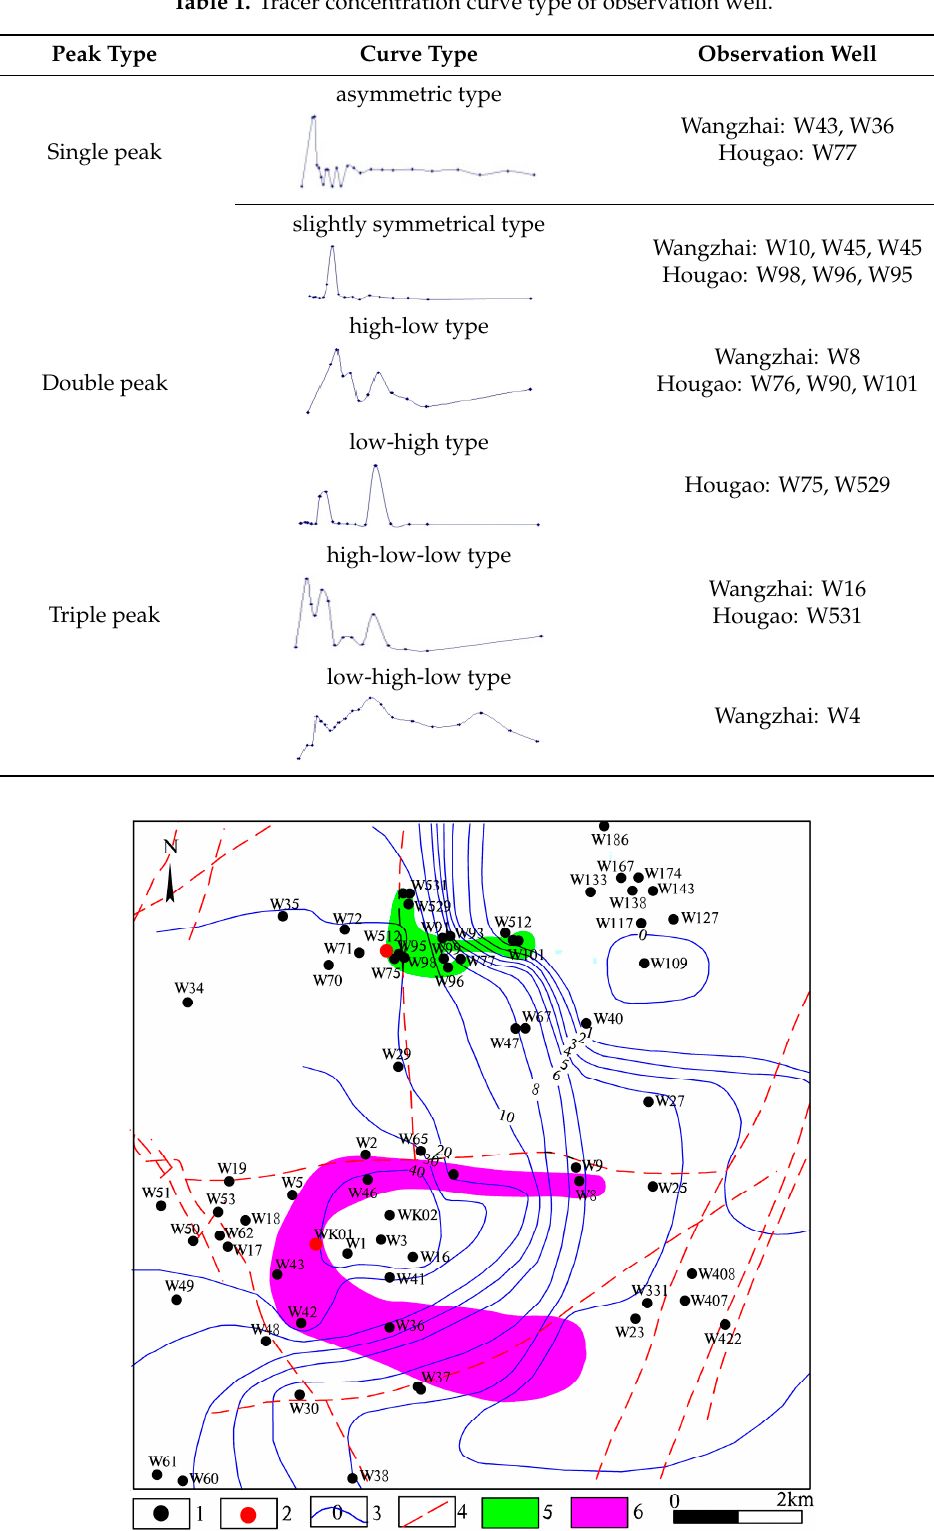
Table 1. Tracer concentration curve type of observation well.